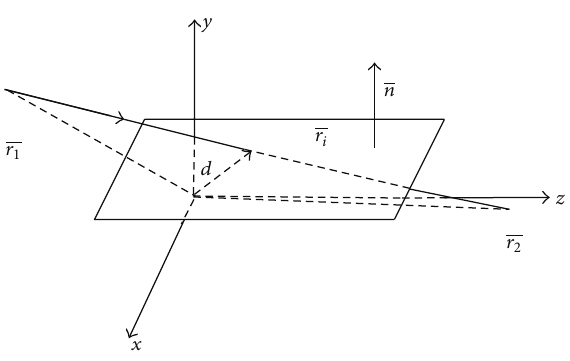
Figure 4: The model of intersection